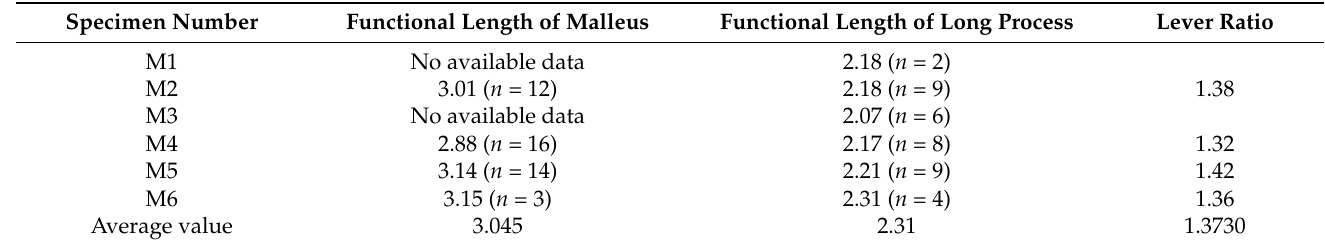
Table 11. The malleus/incus lever ratios for the green monkey individuals